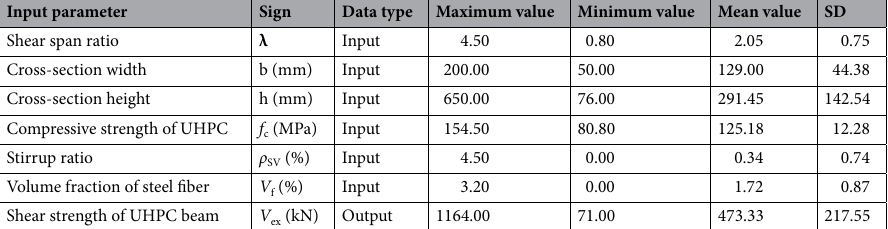
Table 5. Statistical analysis of the